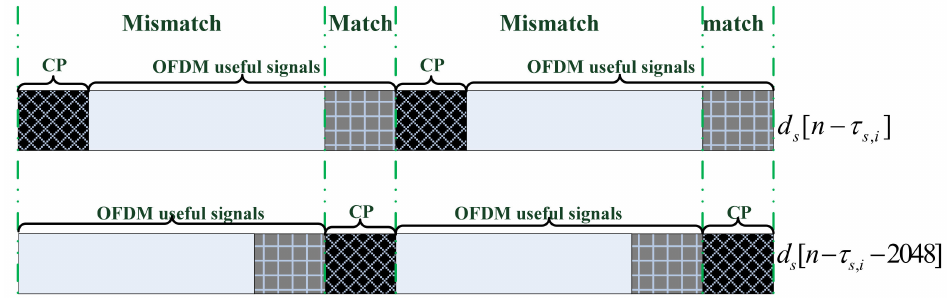
Figure 7. Cyclic autocorrelation of the LTE